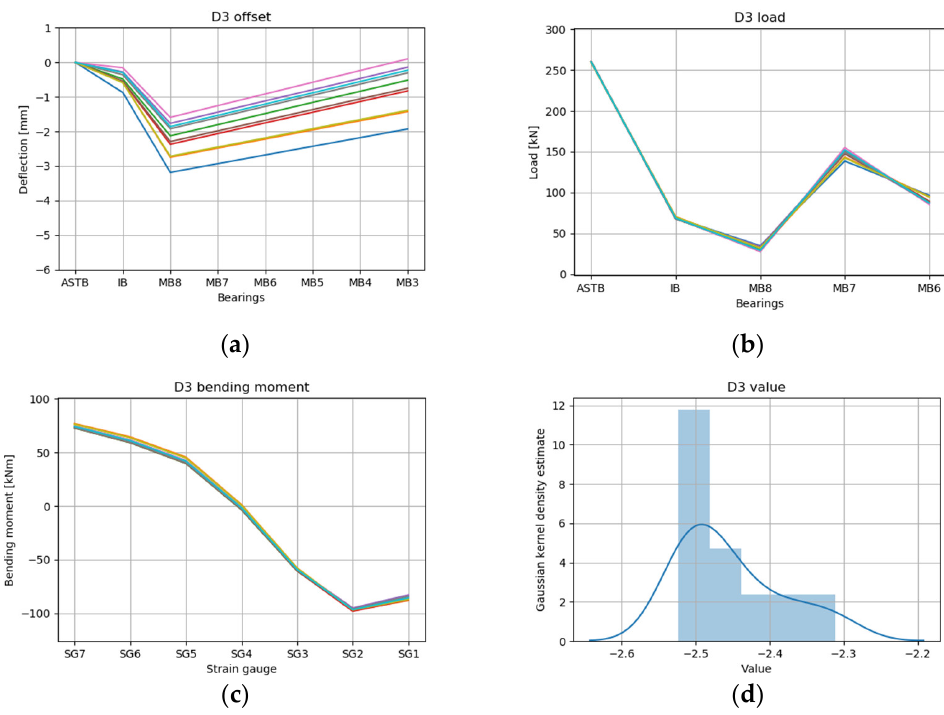
Figure 19. RL results for draft condition D3 top 10 cases: ( a ) offset, ( b ) load, ( c ) bending moment, and ( d ) value.